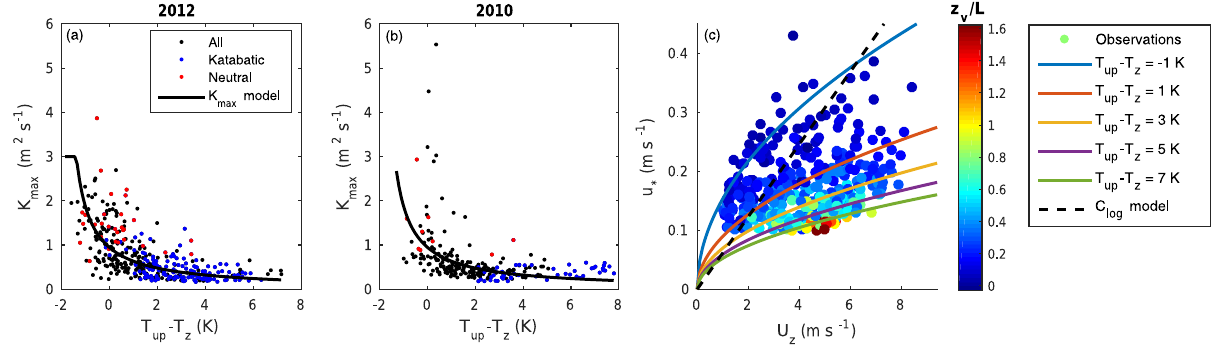
Figure 11. (a–b) K max vs. air temperature difference between AWS up and AWS glac , for the 2012 and 2010 seasons. Black (blue) circles represent all (katabatic) observations, and black line is the empirical fit model for K max . (c) OPEC-derived 30min friction velocity u ∗ vs. observed wind speed U z , for the 2012 season, where each observation point is colored according to its 30min value of OPEC-derived z v v (color bar). Solid colored lines are modeled u ∗ , using the K Int method with H k = 20m and optimized K max , for five different stability conditions ( T up − T z = − 1, 1, 3, 5, and 7K). Dashed line is modeled u ∗ using the C log